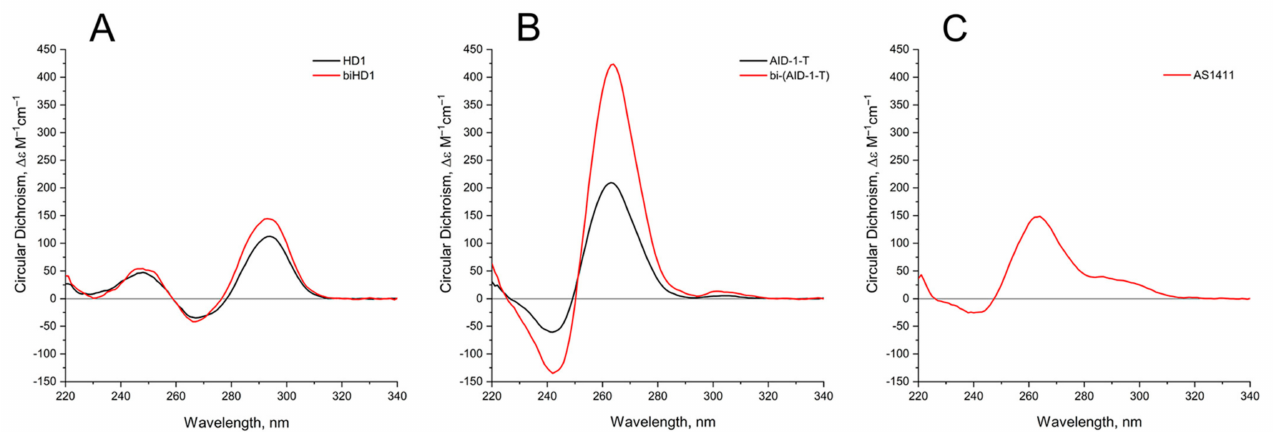
Figure 2. Circular dichroism (CD) spectra of the GQs under study in the buffer B (140 mM NaCl and 10 mM KCl) at 20 ◦ C: ( A ) HD1 (black), bi-HD1 (red); ( B ) AID-1-T (black), bi-(AID-1-T) (red); ( C )